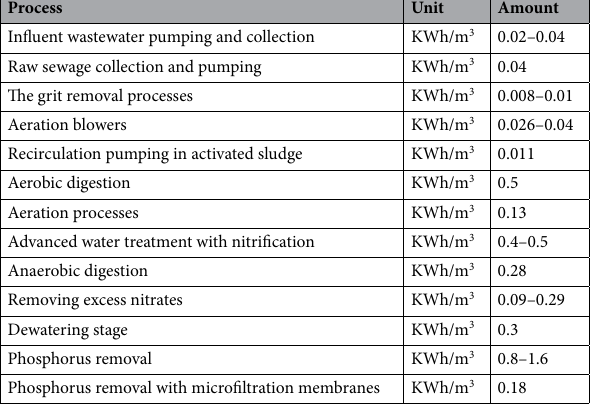
Table 17. Energy consumption intensity for wastewater treatment plant’s processes 92 .